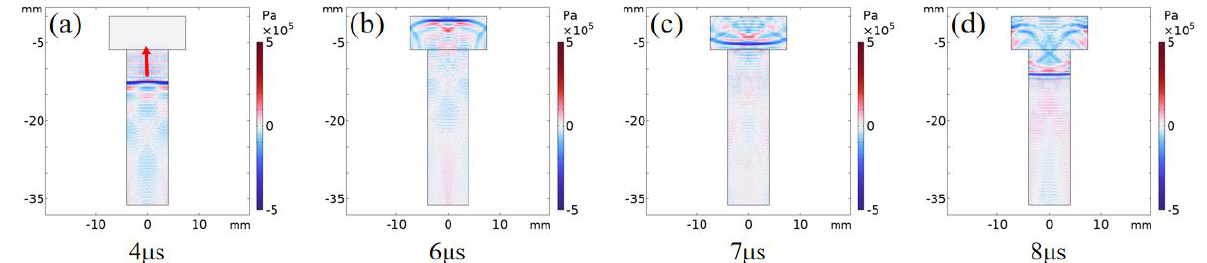
Figure 5. Displacement of the mechanical vibration caused by thermo − elastic effects in the bolt; dis- semination process: ( a ) → ( b ) → ( c ) → ( d ).